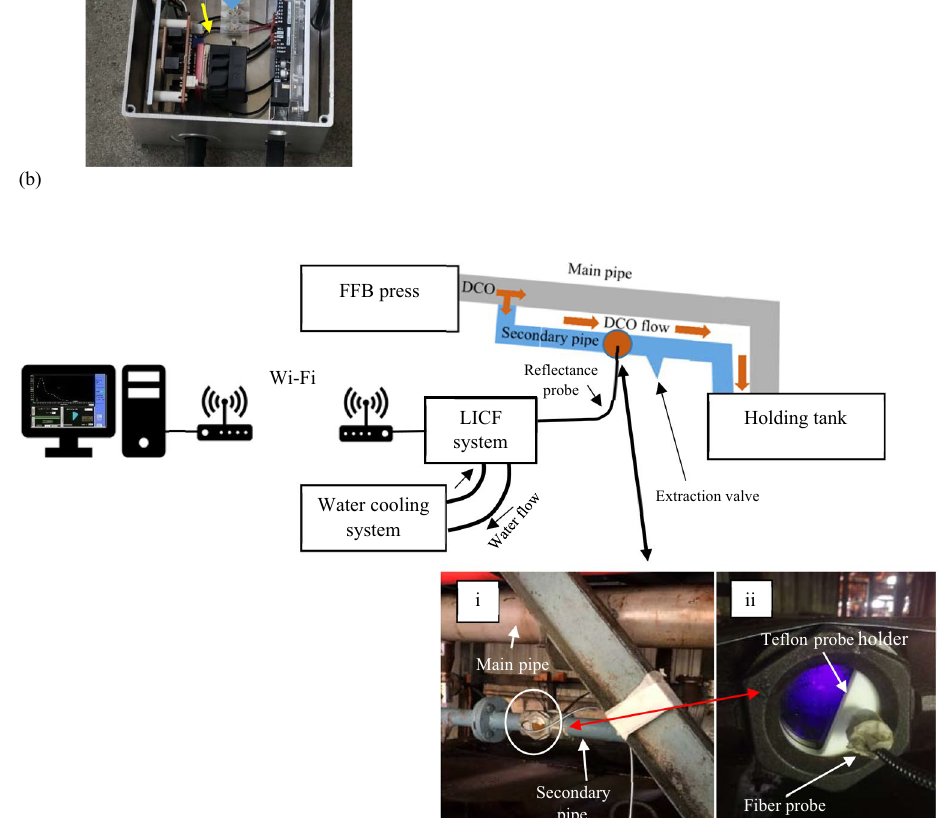
Figure 2. ( a ) LICF prototype light source system which include water-cooled heat-sink for keeping the LED light source from overheating, LED driver and Arduino board for collecting temperature sensor data. ( b ) Flow chart of oil palm FFB processing at palm oil mills and in-line Chlorophyll LICF prototype setup implemented at dilution & oil classification point, Bukit Kerayong oil mill, Malaysia. (i) The DCO, after pulp pressing, will flow through the main pipe to the holding tank. A secondary pipe is installed under the main pipe for the installation of the LICF probe. (ii) LICF probe being held by a teflon probe holder. The probe is separated from the DCO via a sapphire window. The telfon probe holder is designed to have an opening to enable visual inspection of DCO